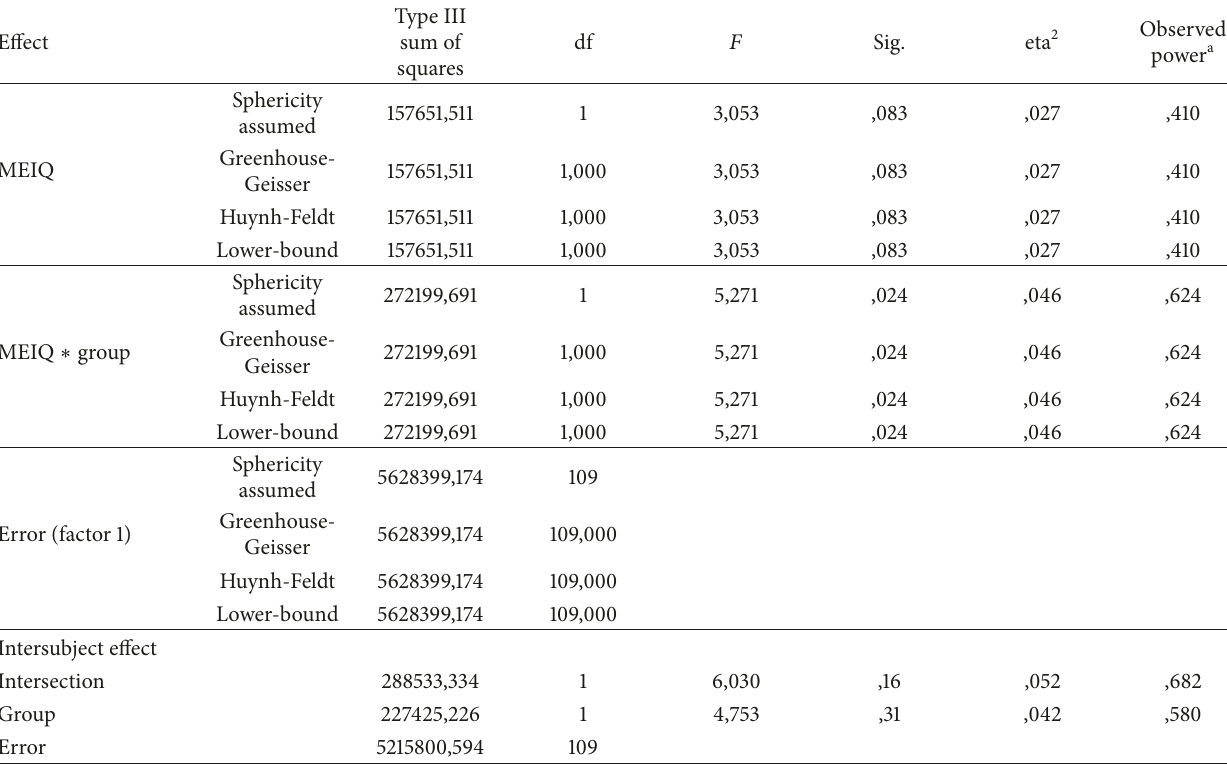
Table 7: MEIQ intrasubject and intersubject effects.